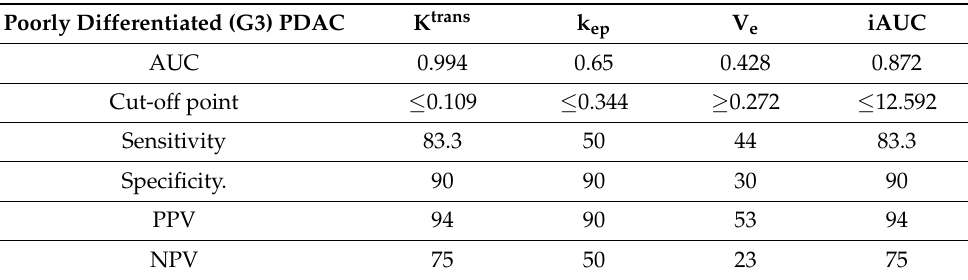
Table 6. Analysis of the poorly differentiated (G3) PDAC.